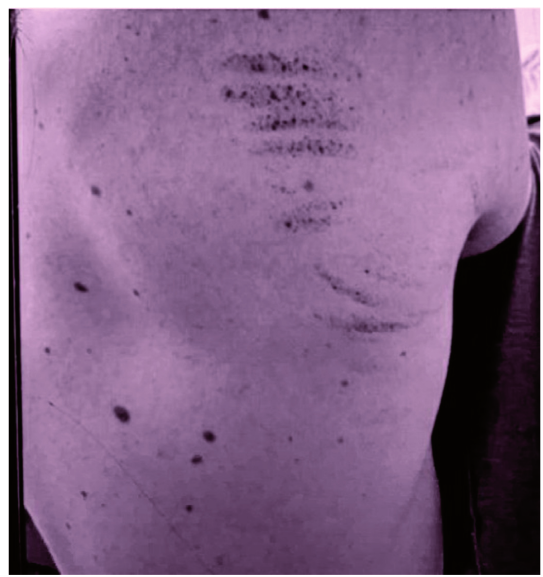
Figure 1: Petechial rash along the right scapula.